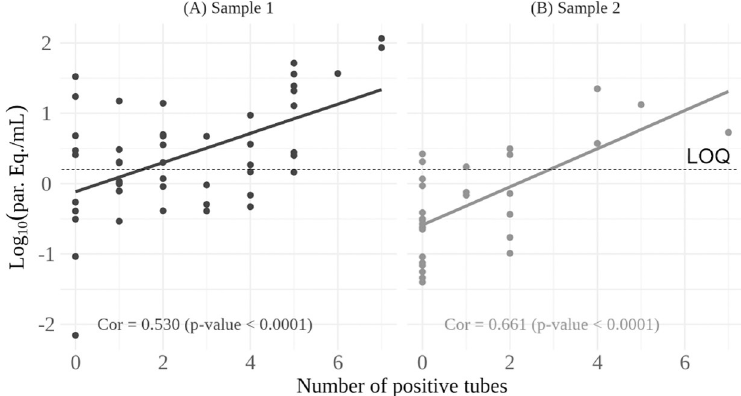
Fig 4. Correlation between parasite load and number of blood culture positive tubes in patients with chronic Chagas disease. The number of positive qPCR results for the first and second clinical samples was respectively, 49 (A) and 30 (B) . LOQ: Limit of Quantification